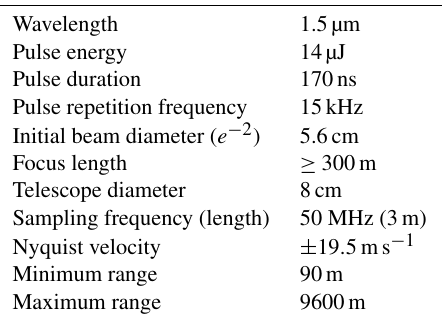
Table 1. Main parameters of the HALO Photonics Stream Line li- dar.